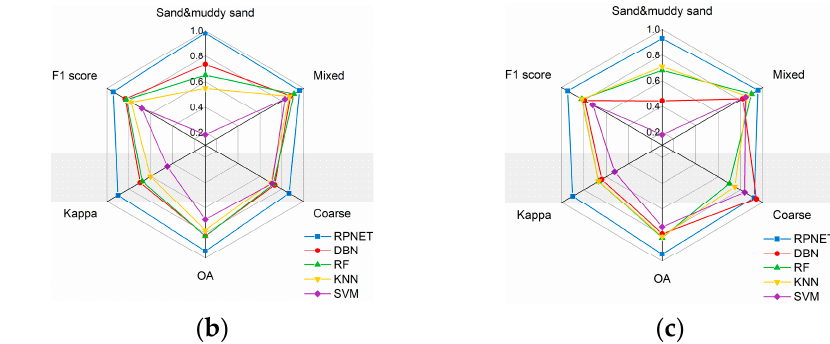
Figure 15. Comparison of different classifiers when the number of training samples decrease in S1.